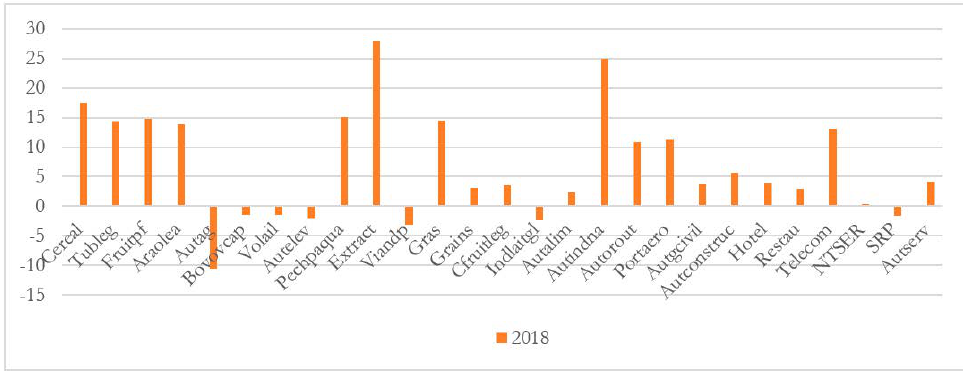
Figure 5. Evolution of sectoral added value (in% compared to the BAU scenario). Source: Authors, based on simulations.